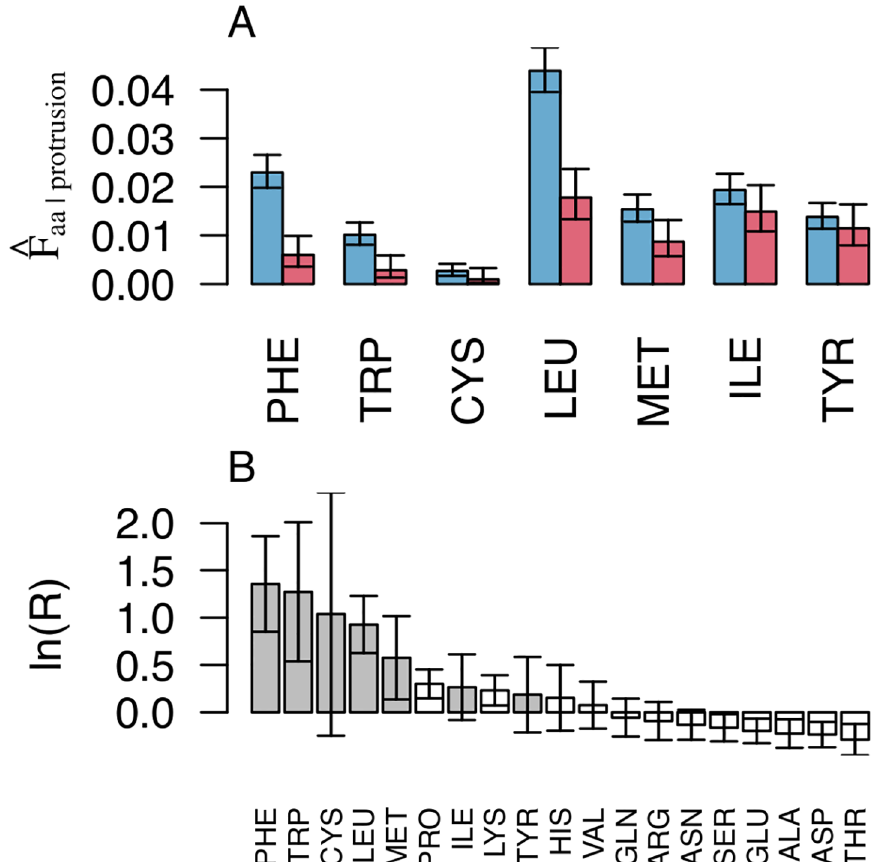
Fig 10. Large aliphatic and aromatic side chains are over-represented on protrusion on peripheral proteins. Panel A shows the weighted fractions (Eq 4) of hydrophobic amino acids on protrusions from peripheral proteins (blue) and from proteins in the reference set (red, ‘Non-binding surfaces’). In panel B, the contrast between the two sets is quantified by the odds ratio (Eq 10), so that positive values reflect higher frequencies in the set of peripheral proteins than in the reference set. More precisely the vertical axis denote ln R ð peripheral ; reference ; ^ F representing each of the standard amino acids. Error bars are 95% confidence